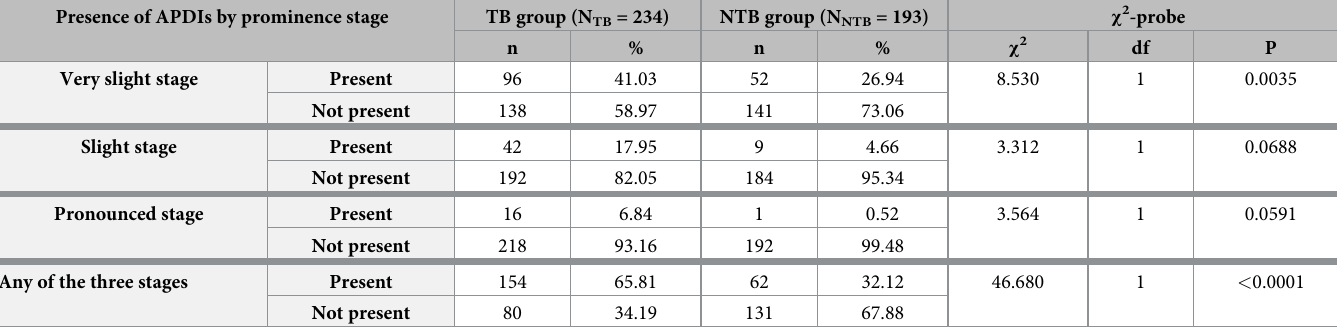
Table 3. Summary of the statistical results, considering the different stages of the prominence of APDIs. Presence of APDIs by prominence stage